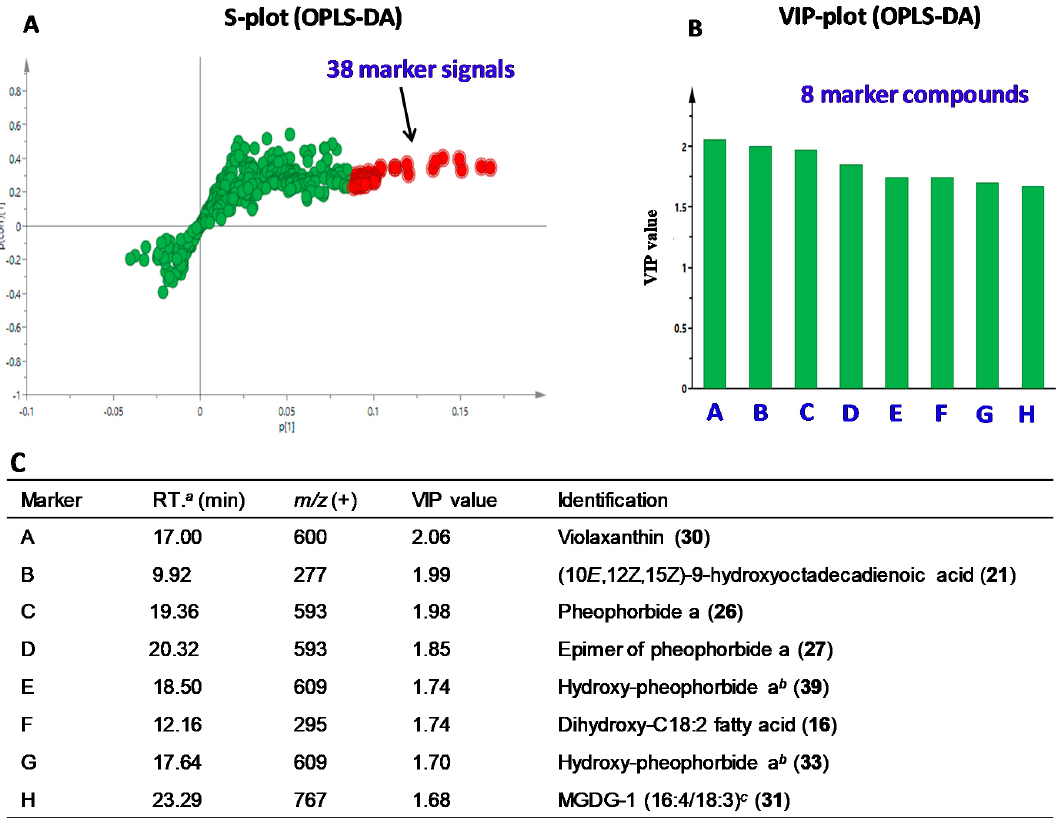
Figure 2. Prediction of anti-inflammatory marker compounds by chemometrics: ( A ) OPLS-DA S-plot of chromatographic signals of 21 column fractions generated from the positive ESI-MS with 38 marker signals (VIP > 1.5) highlighted in red; ( B ) VIP plot showing 8 marker compounds corresponding to 38 marker signals; and ( C ) chromatographic and MS information of the 8 marker compounds.